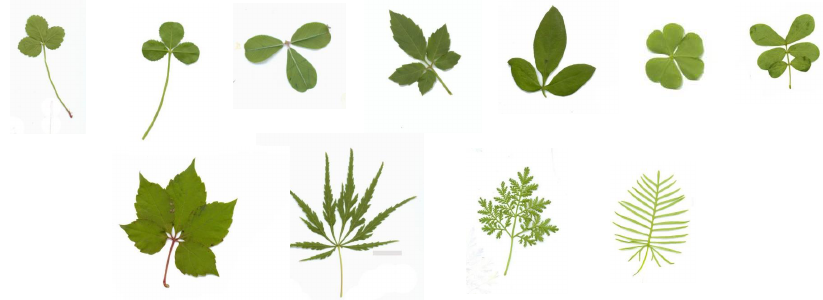
Figure 9. Example images from ICL compound dataset, one image for each species. Table 7. Classification accuracy (%) comparison on ICL compound dataset with identical settings.